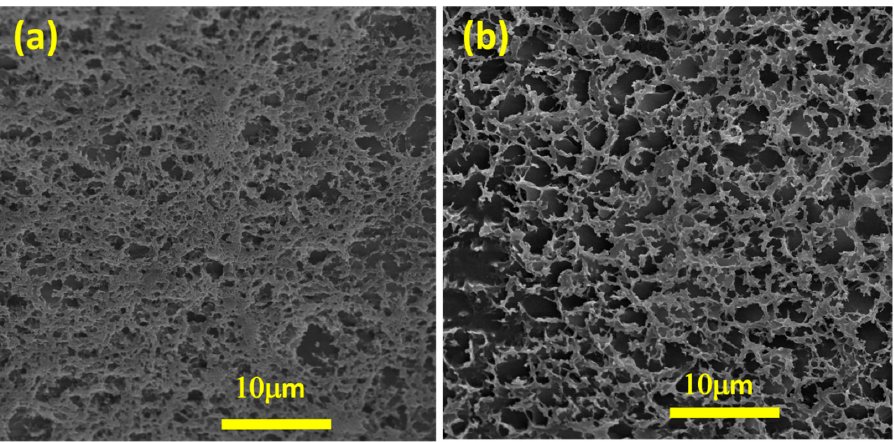
Figure 3. Representative FE-SEM images of ( a ) CS–CPF and ( b ) CS–CPF containing Au-decorated cellulose nanofibers.